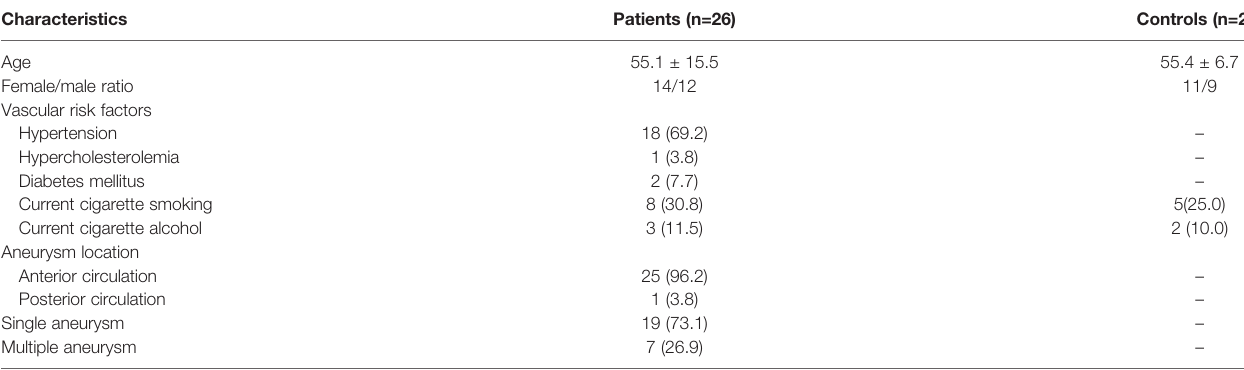
TABLE 1 | Demographic and clinical characteristics in patients with